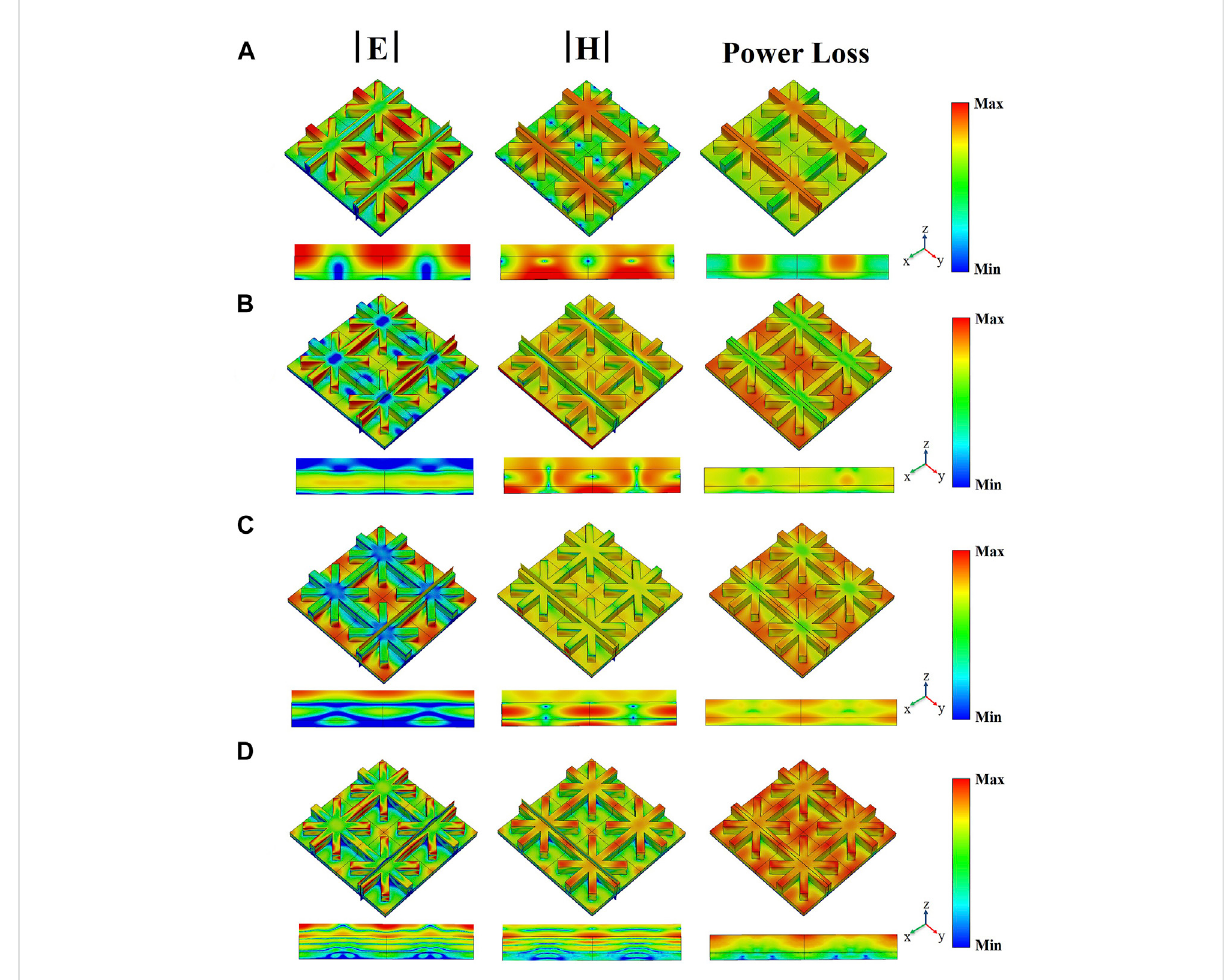
FIGURE 10 Distributions of the electric fi eld, magnetic fi eld and power loss of the double-cross shape metamaterial structure at four different frequency positions: (A) 6.1 GHz; (B) 10.4 GHz; (C) 16.3 GHz; (D) 40